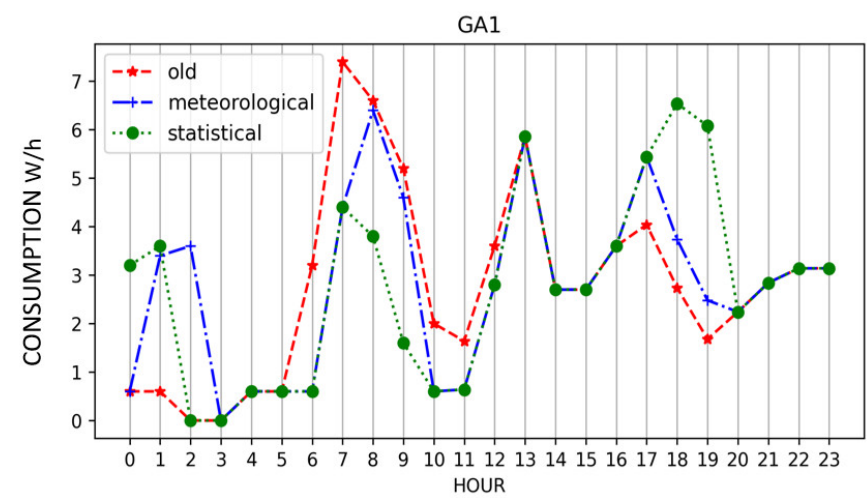
Figure 2. The optimized household appliance scheduling for the first user.